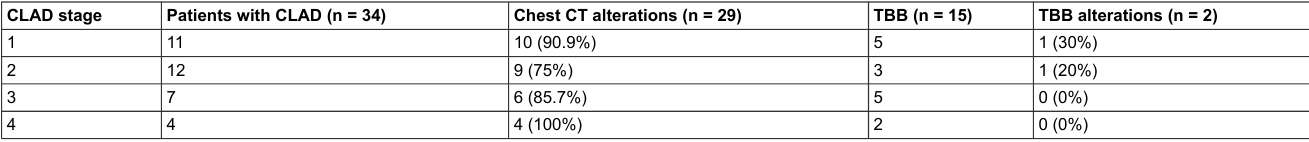
Table 3: Chest computed tomography and transbronchial biopsy (with chronic lung allograft dysfunction group). Values are displayed as n (%). CLAD